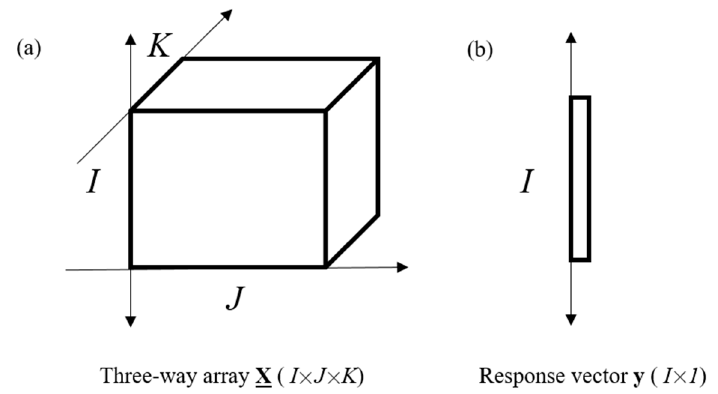
Figure 5. ( a ) Representation of the three-way array ( X ); and ( b ) response vector y [18].